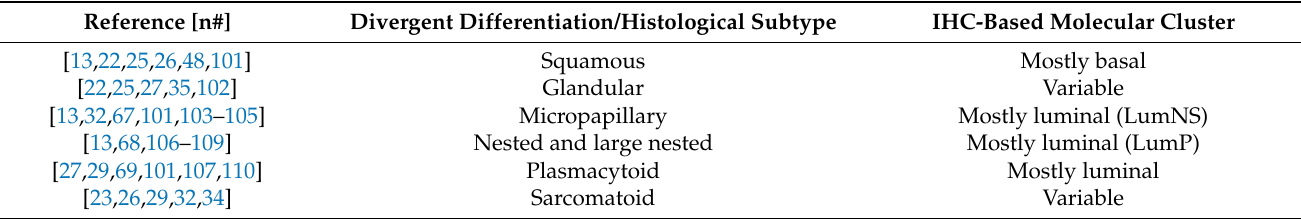
Table 2. IHC-based subtyping of urothelial carcinomas with divergent differentiation or belonging to distinct histological subtypes. IHC: immunohistochemistry; LumNS: luminal non-specified; LumP: luminal